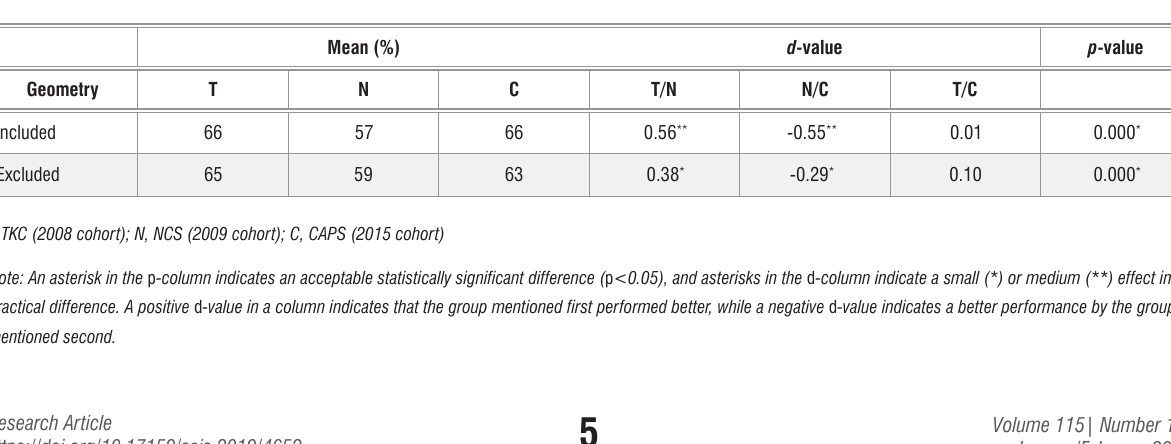
Comparison on overall performance